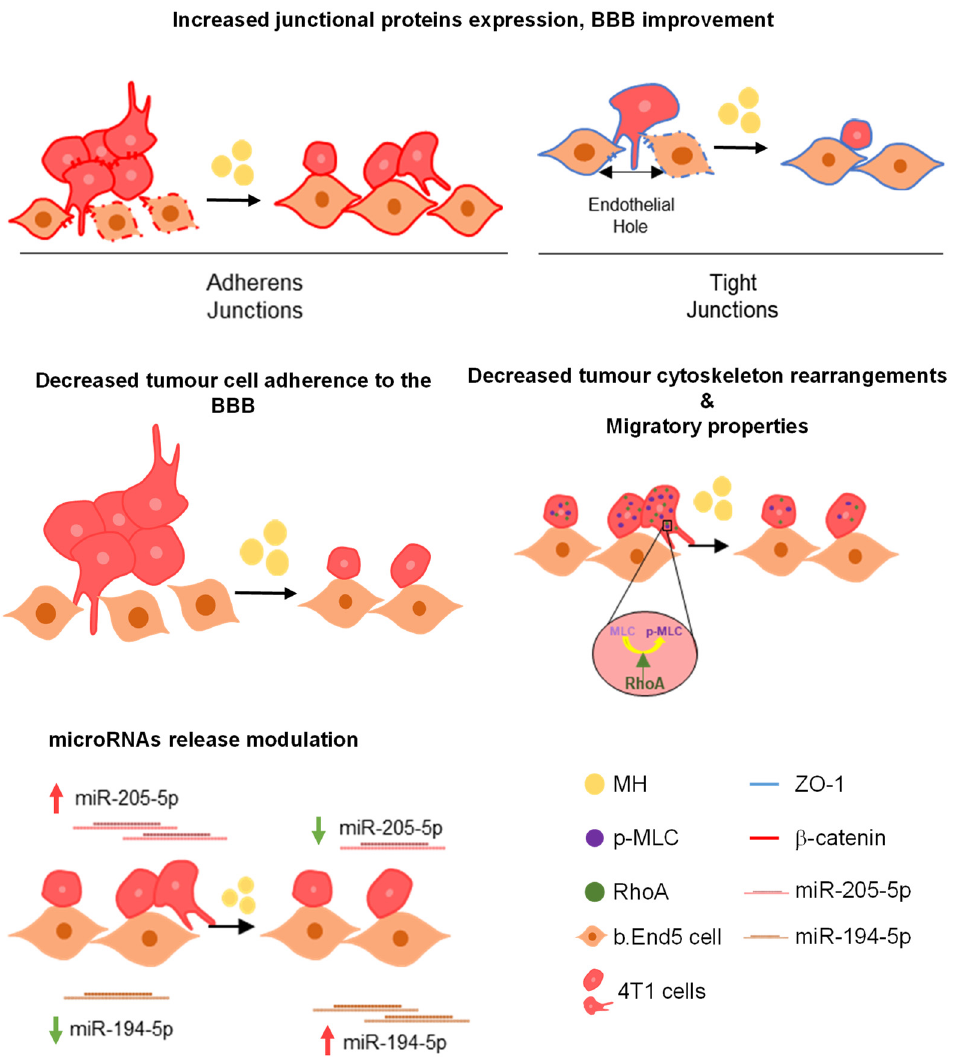
Figure 11. MH’s protective action on brain endothelium and inhibition of metastatic properties of tumour cells. MH is able to boost BBB properties and maintain the brain endothelial monolayer by improving AJs and TJs and preventing membrane gaps formation in b.End5 cells exposed to 4T1 cells. Moreover, MH is able to prevent 4T1 cells adhesion to brain endothelium and to decrease their migratory properties, apparently by decreasing p-MLC via downregulation of RhoA. MH is also able to prevent miR-205-5p and miR-194-5p changes, by decreasing the former and increasing the latter.